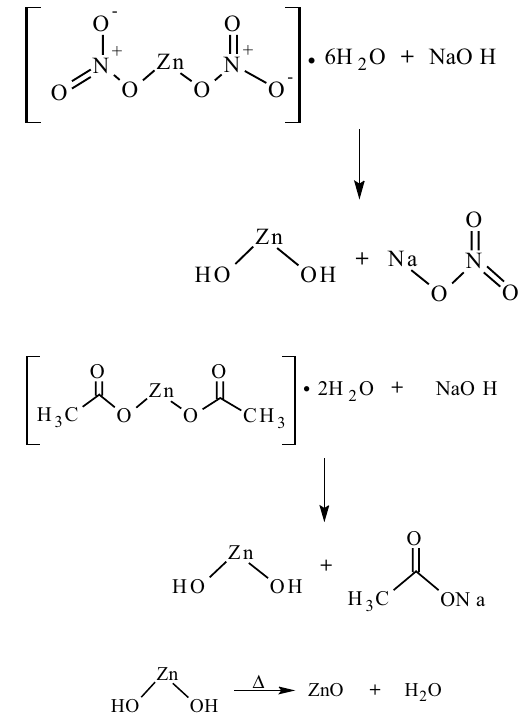
Fig. 6 Reaction mechanism of ZnO for the synthesis of